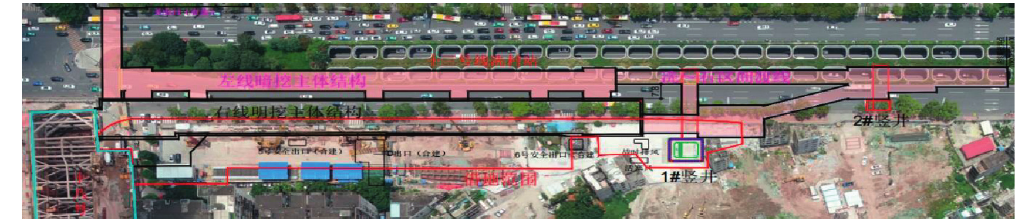
Figure 1: General layout of underground excavation tunnel interval.